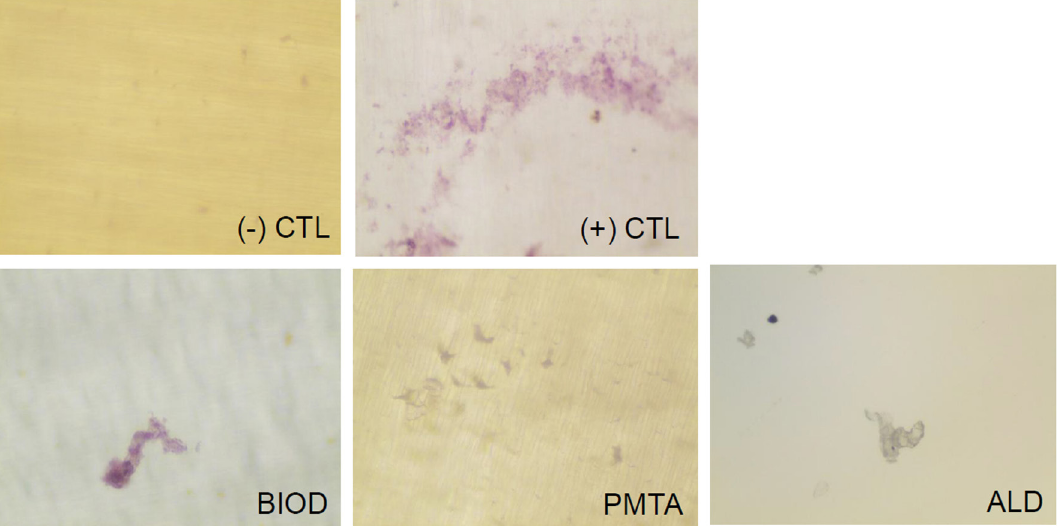
Figure 5- Resorptive activity of OCLs treated with or without CSCs or ALD. CSCs and ALD showed an inhibitory effect on osteoclast function. Pit formation was confirmed as something purple on the smooth disc. ALD=alendronate; BIOD=Biodentine; CSCs=calcium silicate-based cements; OCLs=osteoclasts; PMTA=ProRoot